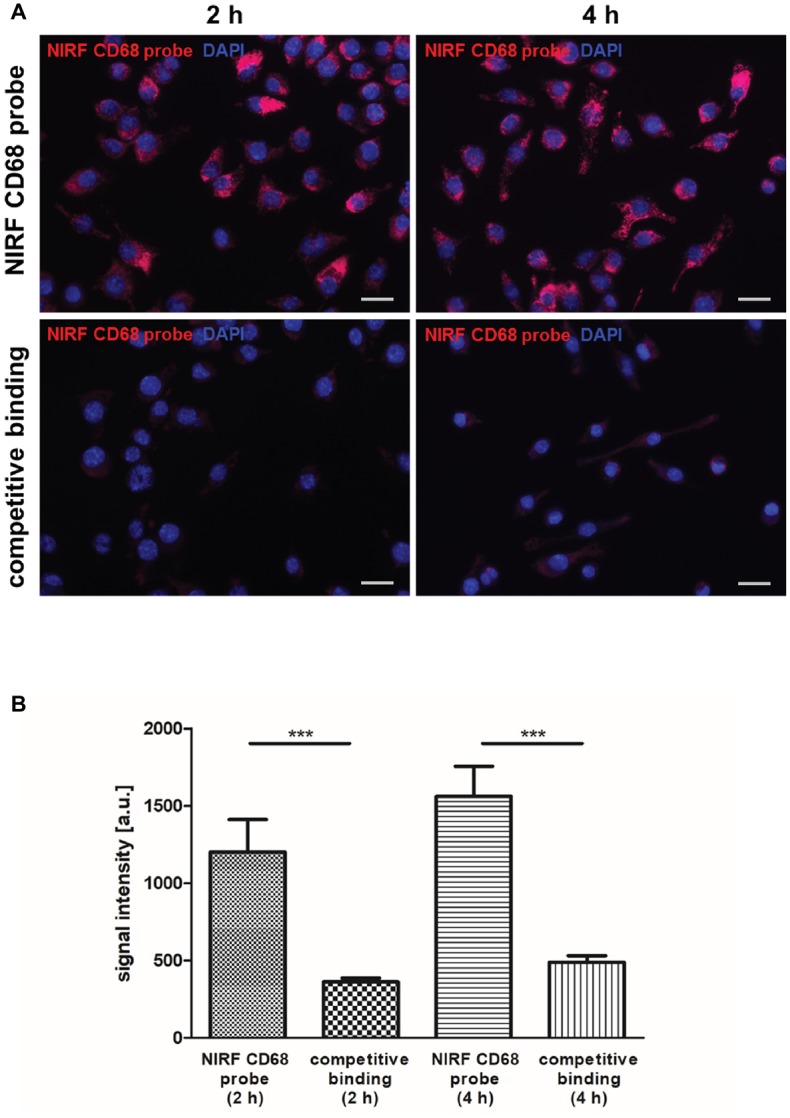
In vitro competitive binding analysis of the NIRF CD68 probe. To test the binding specificity of the NIRF CD68 probe, J774A.1 macrophages were incubated for 2 and 4 h with the NIRF CD68 probe alone (NIRF CD68 probe) or with the NIRF CD68 probe and a 10-fold molar excess of unlabeled anti-CD68 antibody (competitive binding). (A) Fluorescence images show a high fluorescent signal at 695 nm in macrophages after 2 and 4 h of incubation with the NIRF CD68 probe. Competitive binding results in a strongly reduced signal. NIRF CD68 probe in red, counterstaining of the nuclei with DAPI in blue, scale bar = 20 μm. (B) Quantitative analysis of mean fluorescent signal intensities in the NIRF CD68 probe group and in the competitive binding group shows a significantly lower signal intensity as a result of competitive binding (***p < 0.001; data are presented as mean values ± SD). a.u., arbitrary units.